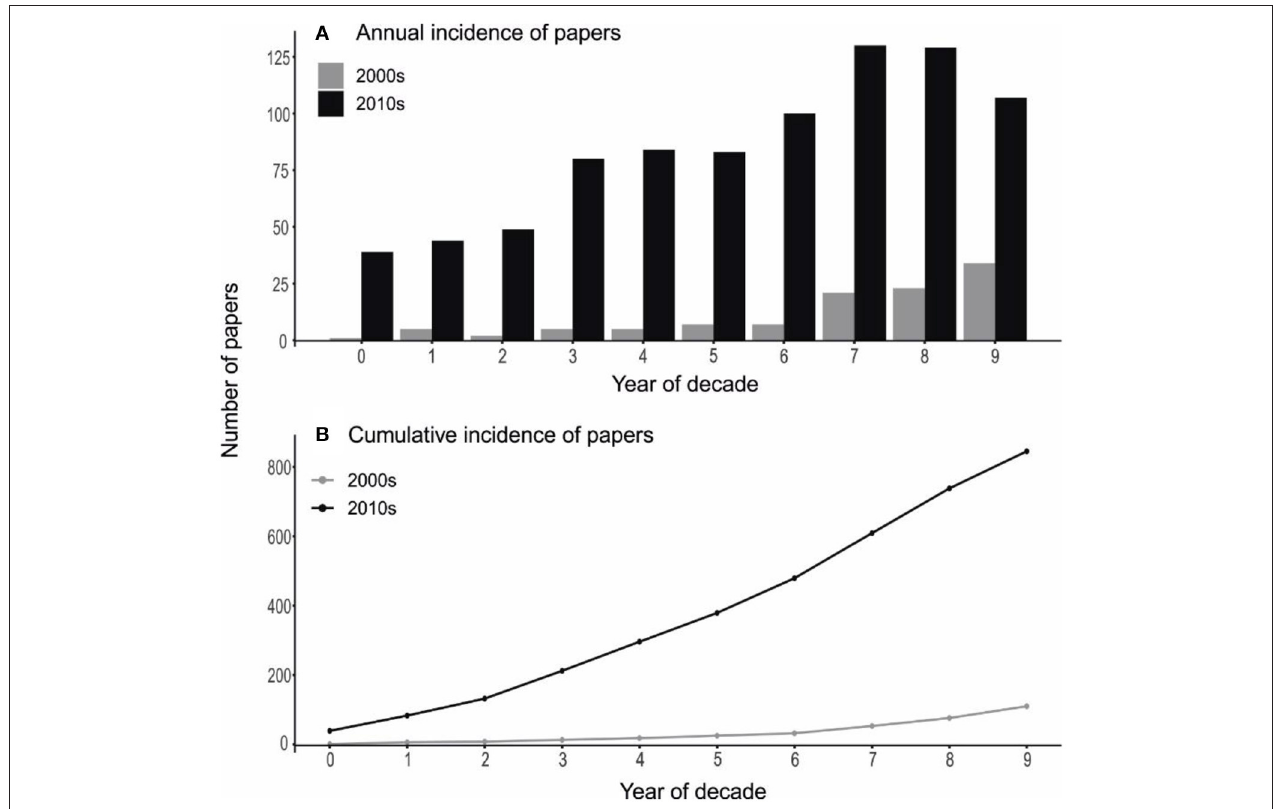
FIGURE 1 | (A) Frequency of Marine Climate Change Experiments (MCCEs) published each year of two decades (2000–2009 vs. 2010–2019) and (B) the cumulative frequency of publications during each past decade.